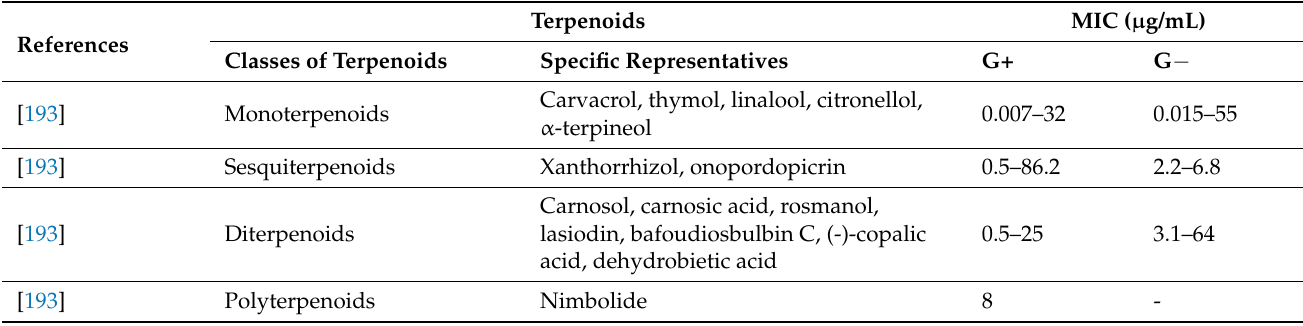
Table 6. The minimum inhibitory concentrations of selected terpenoids against gram-positive and gram-negative bacteria.